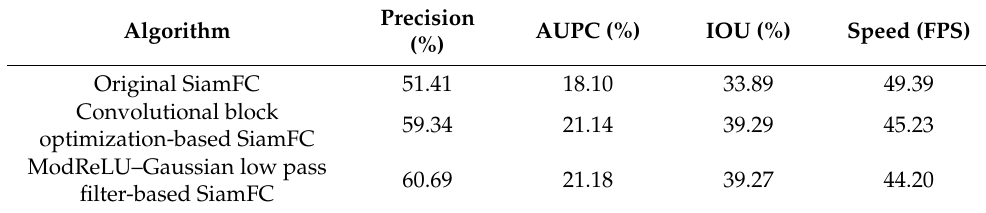
Table 6. Overall results comparison of convolutional block optimization-based SiamFC and ModReLU – Gaussian low pass filter-based SiamFC with original SiamFC.